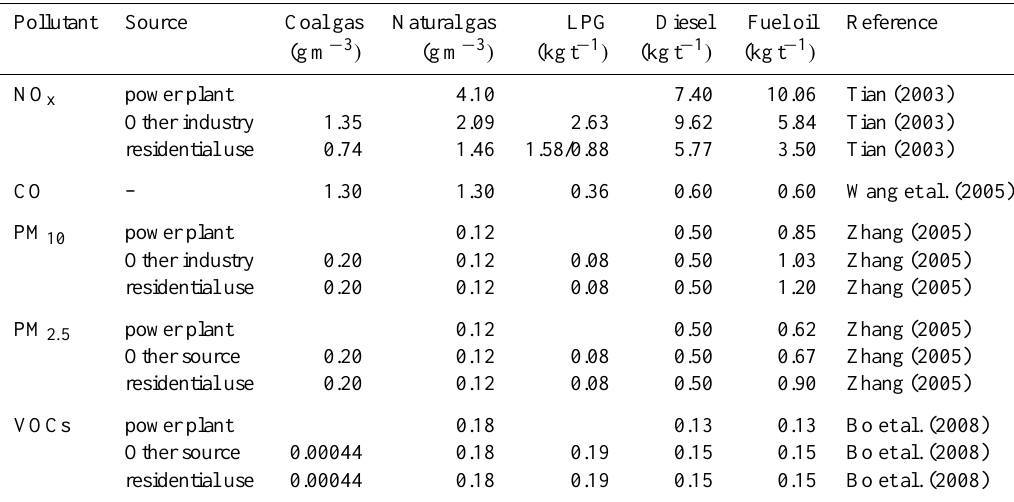
Table 2. Emission factors of other fuel combustion sources in